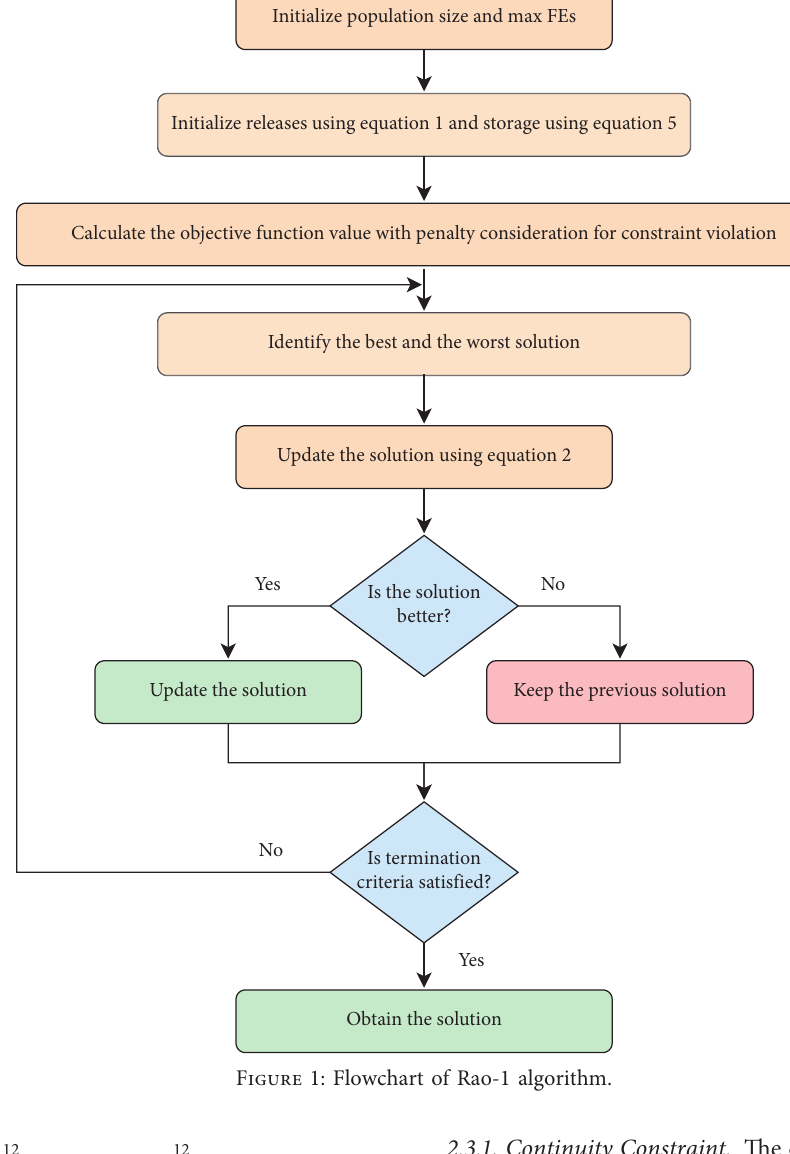
Figure 1: Flowchart of Rao-1